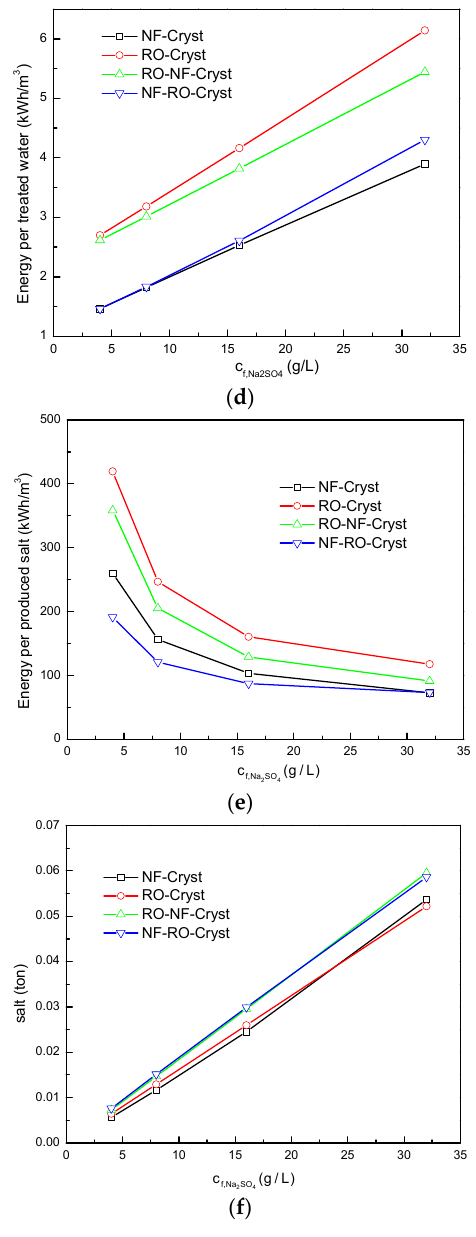
( f ) c ; ( c ) c ; ( d ) E water ; ( e ) E salt ; ( f ) salt production; as a function of Figure 6. ( a ) V 0 /V f ; ( b ) Figure 6. ( a ) V 0 /V f ; ( b ) c r , NaCl ; ( c ) c r , Na r,NaCl ; ( d ) E water ; ( e ) E salt ; ( f ) salt production; as a function of 2 4 , r Na SO 2 SO 4 c at different process configurations under fixed c / c = 1:1. c f , Na at different process configurations under fixed c f , NaCl / c f , Na = f,NaCl 2 SO 4 2 SO 4 2 4 , f Na SO 2 4 , f Na SO c / c 3.2.2. Comparison of Simulation Results under Different f,NaCl 2 4 , f Na SO c of 32 g·L − 1 The comparison of simulation results of different processes under the fixed f,NaCl c / c is shown in Figure 7a–f. From Figure 7a, it can be seen that the RO- and changing f,NaCl 2 4 , f Na SO Cryst process had the lowest V 0 /V f . Even when the feed concentrations of NaCl and Na 2 SO 4 were 32 and 6.4 g·L − 1 , respectively, the V 0 /V f was about 2.6. The NF-Cryst process, operating at a pressure of 4 MPa, achieved a concentration multiple of 12.7 for identical feed concentration. The concentration